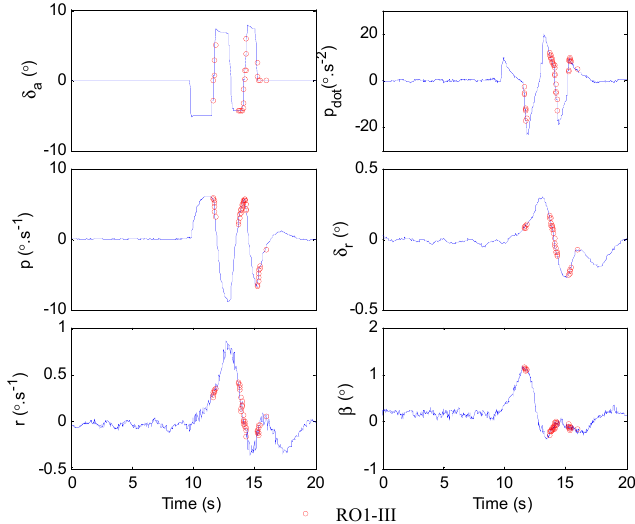
Figure 12. Data segments of response of aileron 3-2-1-1 input for C np identification.